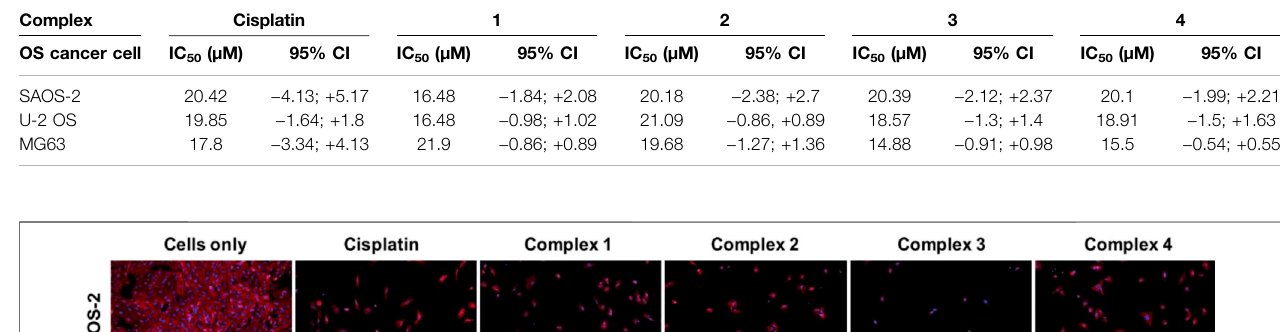
TABLE 1 | IC 50 (µM) values of Cisplatin and complexes 1 – 4 on OS cell lines. Complex